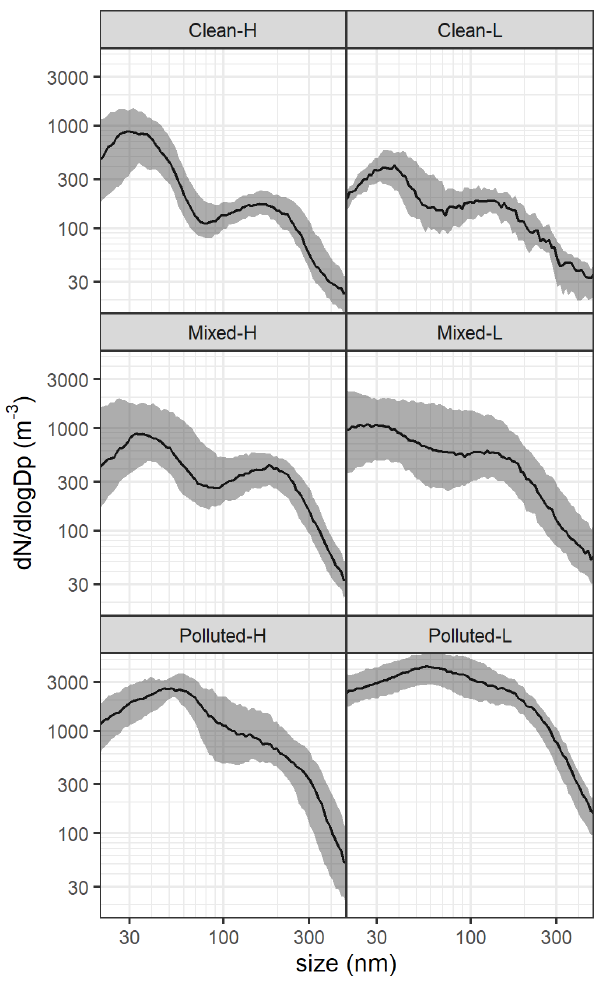
Figure 2. The aerosol number size distribution for different types of air masses. The solid lines represent the median number concentra- tion (d N/ dlog D p ), and the shaded area represents the 25th to 75th percentile.